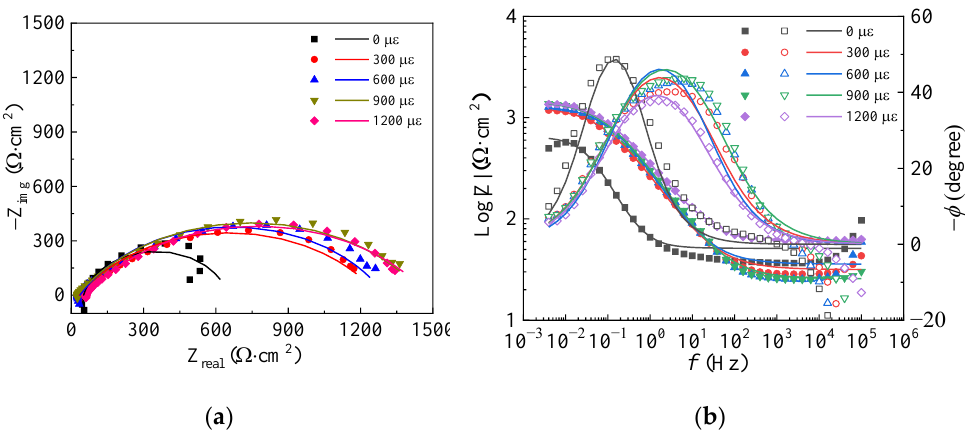
Figure 6. Impedance spectrum of a representative uncoated steel rebar immersed in 3.5 wt.% NaCl solution at different strain levels: ( a ) Nyqusit plots and ( b ) Bode plots.